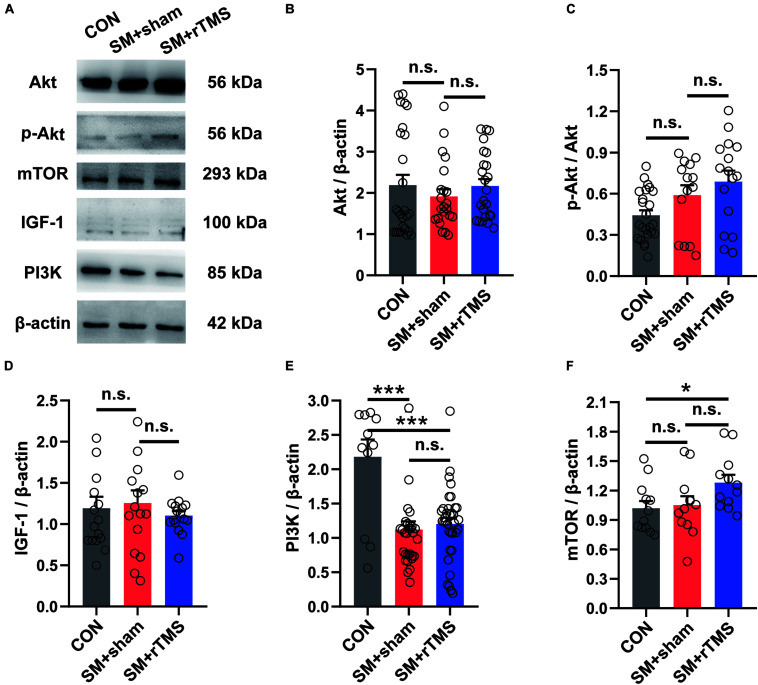
Effects of rTMS on the IGF-1-PI3K-Akt-mTOR signaling pathway in the motor cortex. (A) Representative western blot bands using total protein extracts from the motor cortex. (B–F) Quantification of protein expression levels in the motor cortex among the CON, SM+sham, and SM+rTMS group (n > 10, from five rats in each group). *p < 0.05; ***p < 0.001; n.s., no significant, one-way ANOVA. All values are mean ± SEM.